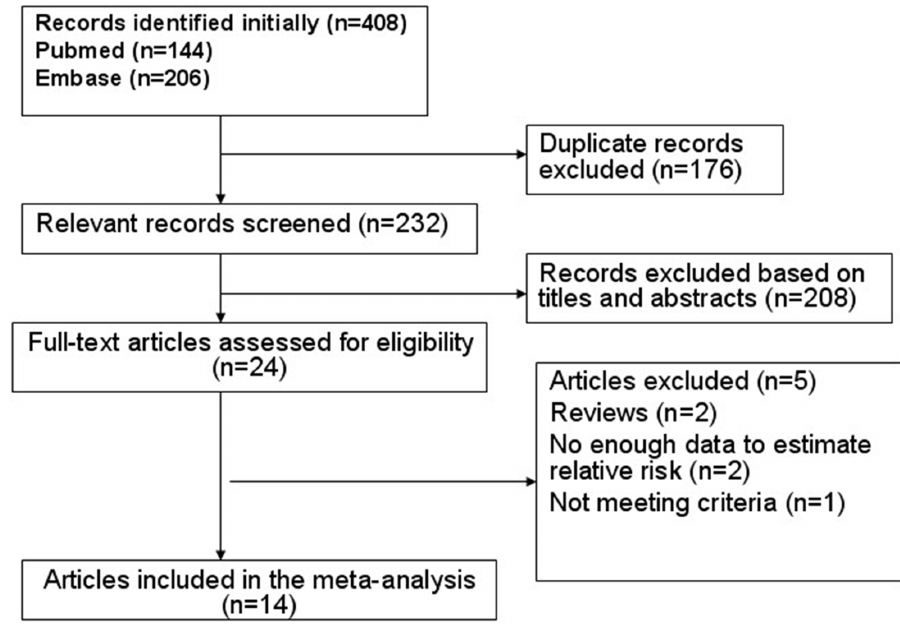
Fig 1. Flow chart of identification of eligible studies to final